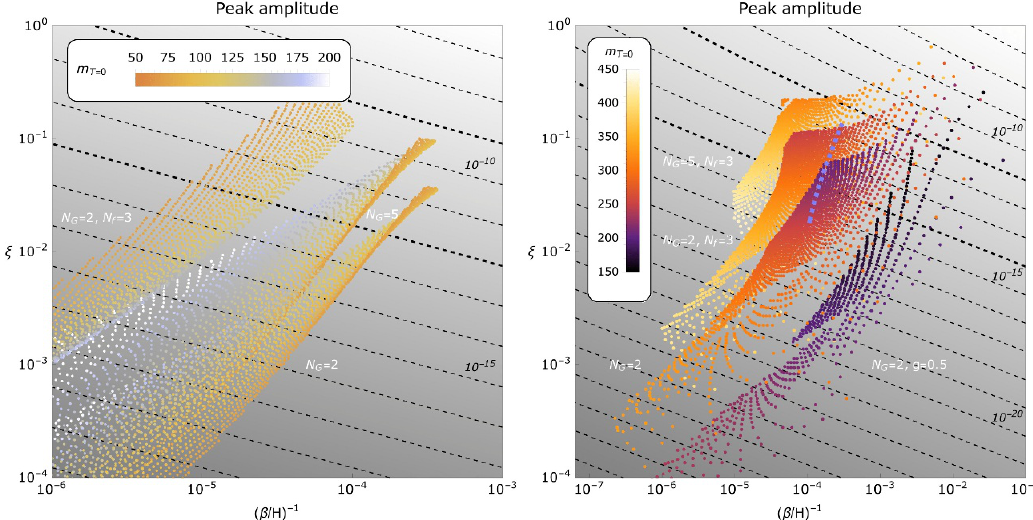
Figure 3 . Thermal parameters from the PT described by Eqs (2.5) (left) and (2.7) (right). The dominant contribution to the spectrum comes from the sound-wave term. The plot points are coloured by their e(cid:11)ective zero temperature mass, found from m 2 = d 2 V=dT 2 evaluated at v . The dashed contours in the plots correspond to the GW amplitude (cid:10) sw (4.7), where we have chosen v w = 0 : 5 in the left plot, and v w = 1 in the right plot (with the corresponding e(cid:14)ciencies from [54]), as motivated using the conditions in [58]. The upper thicker contour corresponds to the LISA 1-year peak sensitivity [59]. The lower thicker dashed contour corresponds to LISA for a power-law spec- trum (integrated over frequency), taken from [60]. The width of the contours is found from varying the zero-temperature potential parameters. Left: unless otherwise indicated, the number of Yukawa couplings is taken to be zero. If present, the Yukawa couplings are set to y (cid:31) = 1. Right: unless oth- erwise indicated, g = 1. The light blue dashed line corresponds to the predictions from the EWPT. scan ranges g 2 (0 : 1 ; 1), and v= (cid:3) 2 (0 : 5 ; 4) In the non-renormalizable case (2.7), we